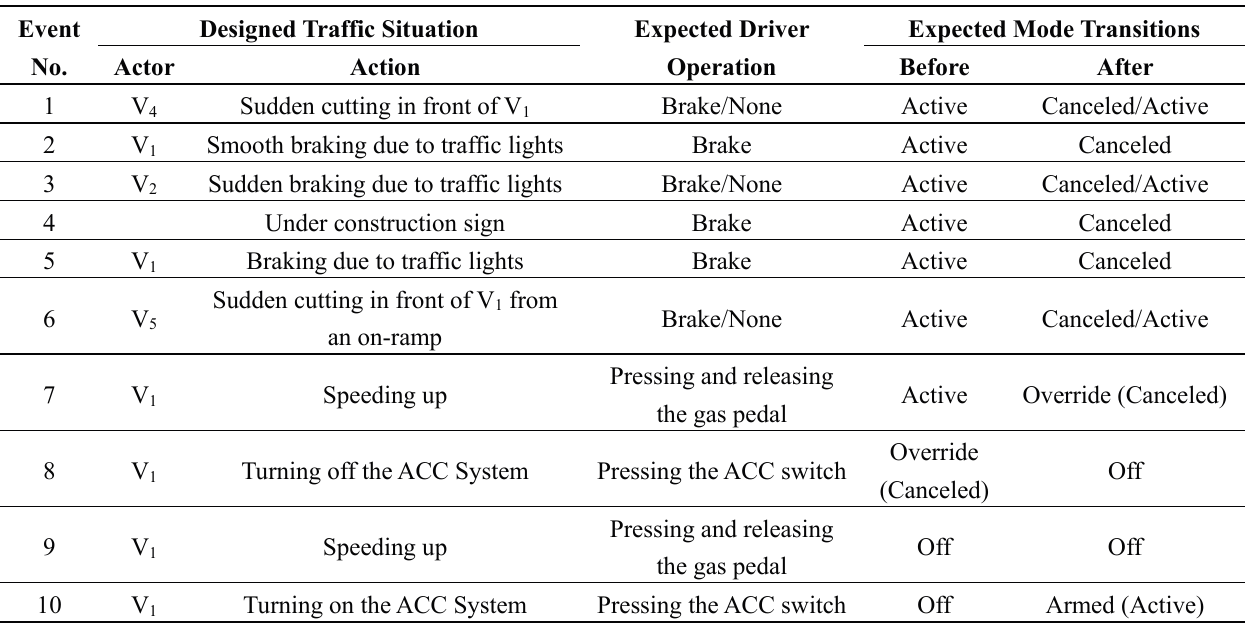
Table 7. Events and their expected mode transitions in the experimental scenario.